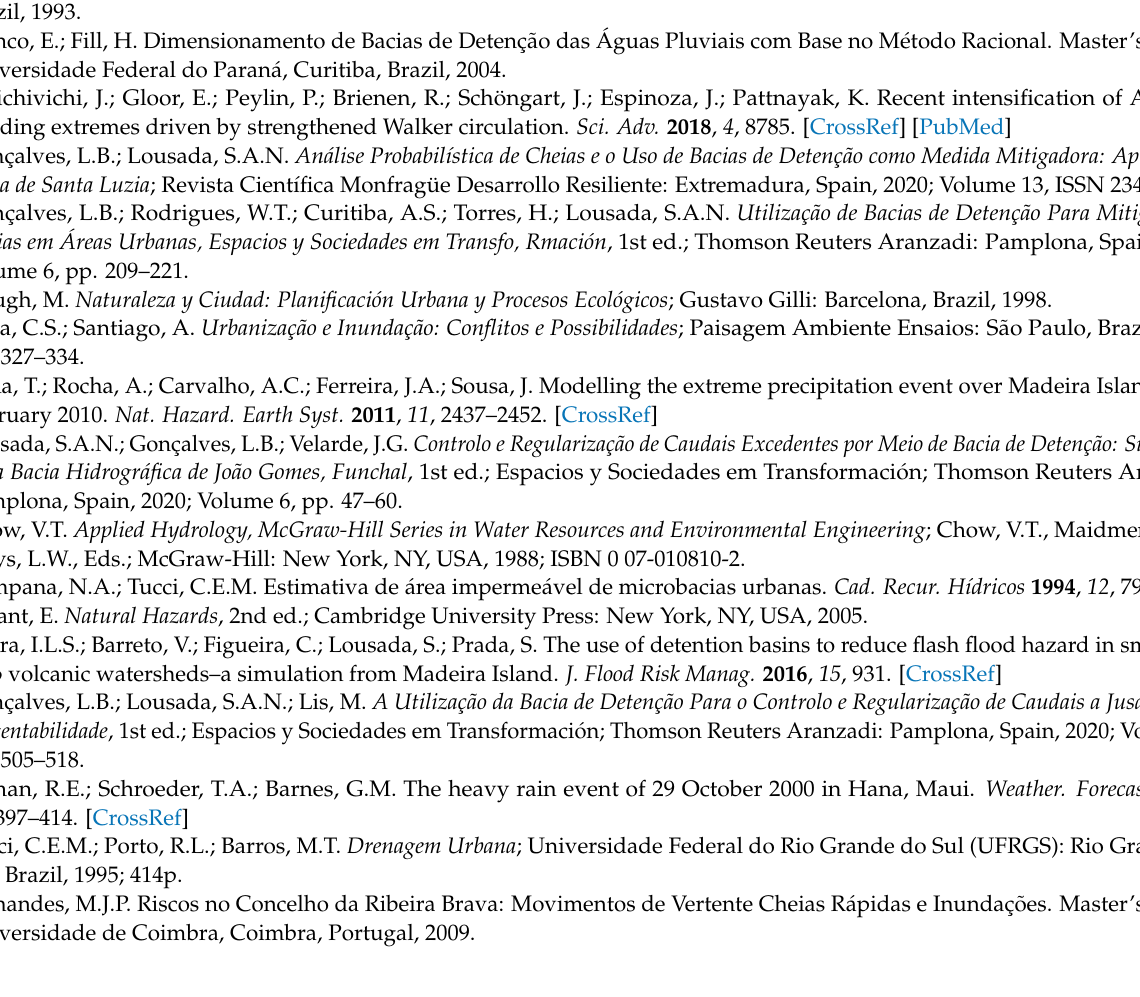
Figure A2. Expected rainfall for Ribeira Brava’s watershed.